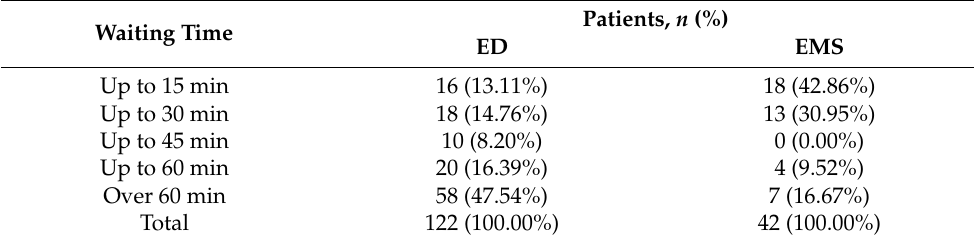
Table 1. Waiting time for admission to the